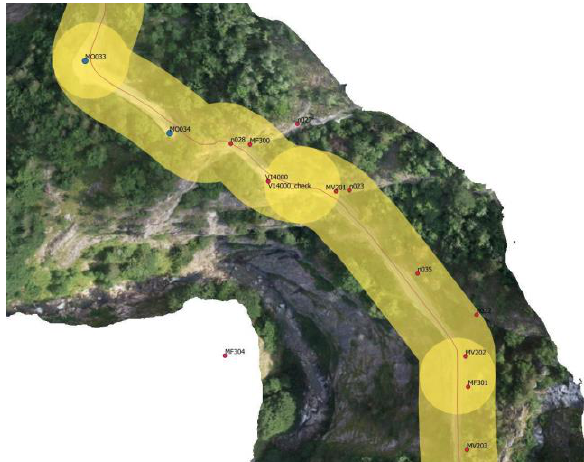
Figure 3. Shape and distribution of measured topographic points.